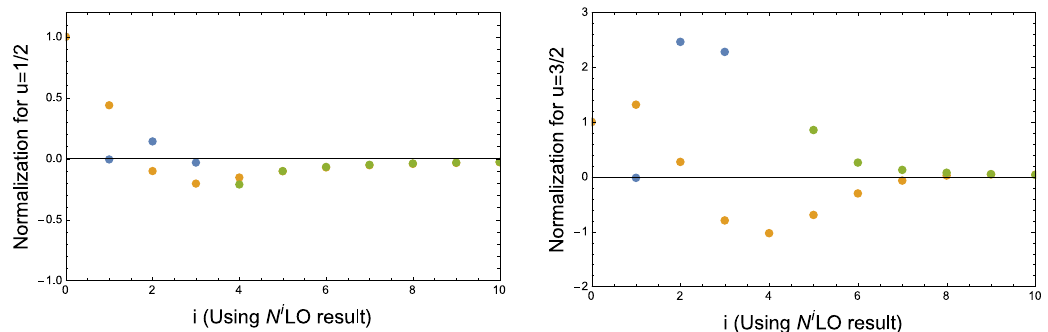
Figure 7 . Estimates of the normalization constants of the renormalons at u = 1 = 2 (left) and 3 = 2 (right) for the momentum-space potential. Green points are obtained from the RG-improved series, while the orange points correspond to the large- (cid:12) 0 approximation. The (cid:12)rst four points of the RG-improved series coincide with the exact (cid:12)xed-order results, shown by blue points. In the right panel the i = 4 point ( (cid:0) 7 : 30) lies out of the plot